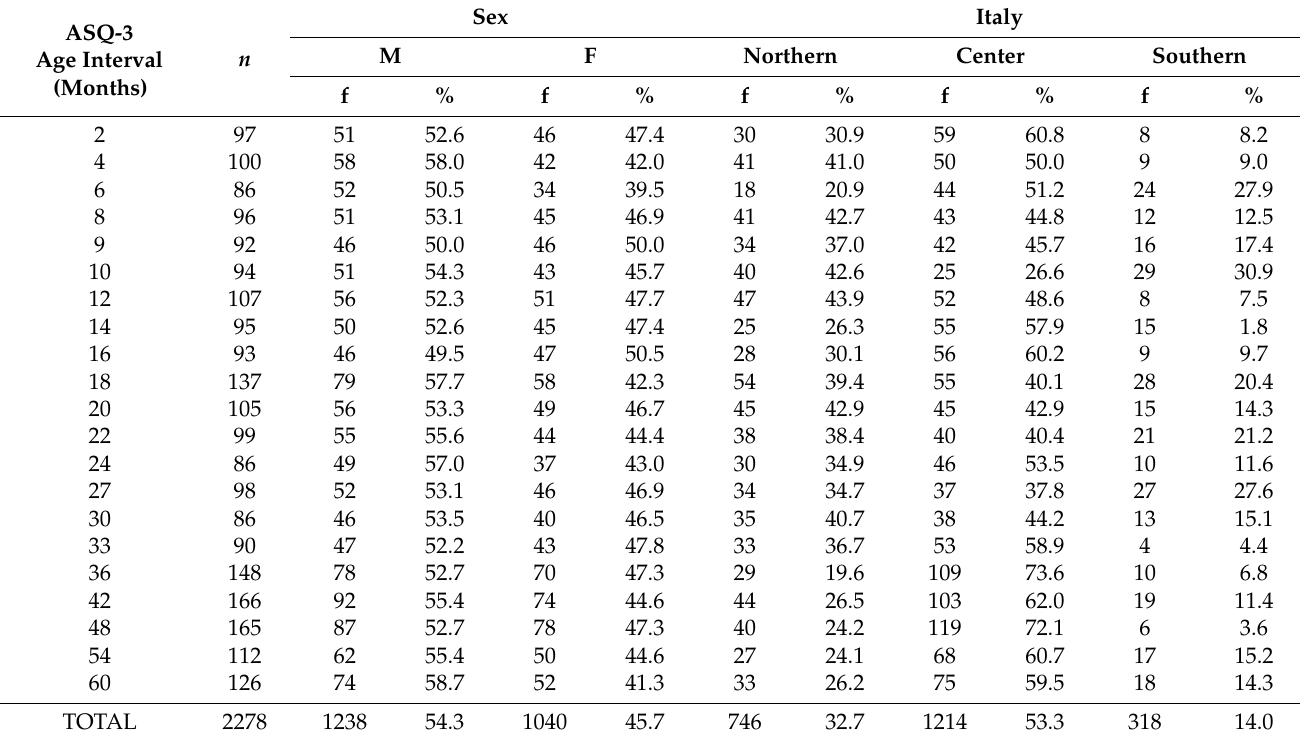
Table 1. Characteristics of the study participants.